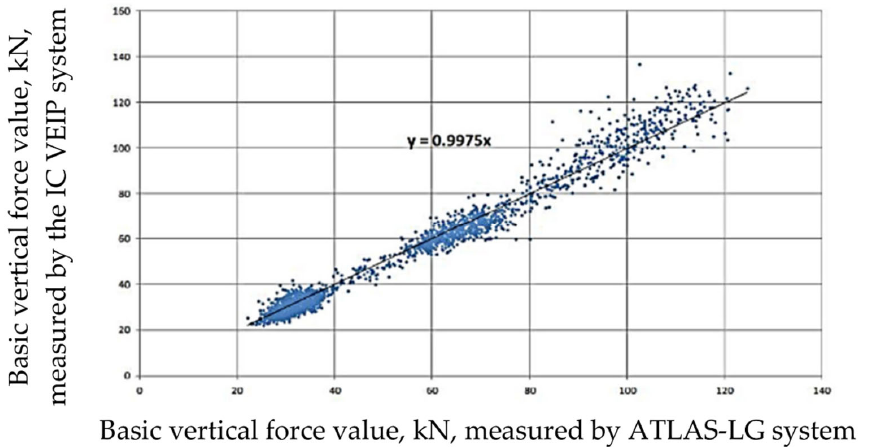
Figure 8. Correlation of measured values of basic vertical forces according to measurement systems.